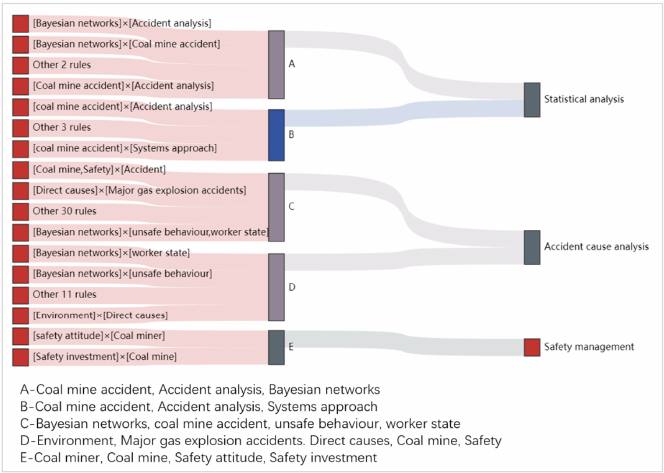
Figure 10. Strong association rules and category of English keywords.